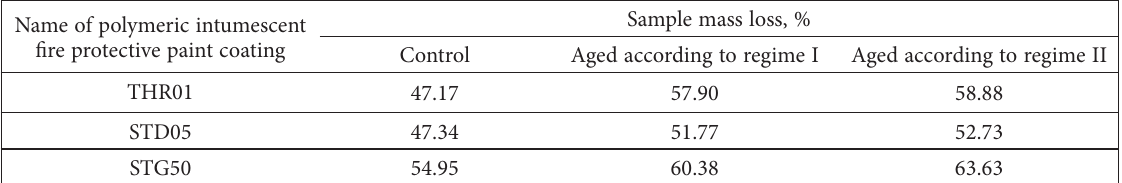
Table 3. Various intumescent fire protective coating mass losses under nitrogen at heating up to 600 °C Name of polymeric intumescent fire protective paint coating